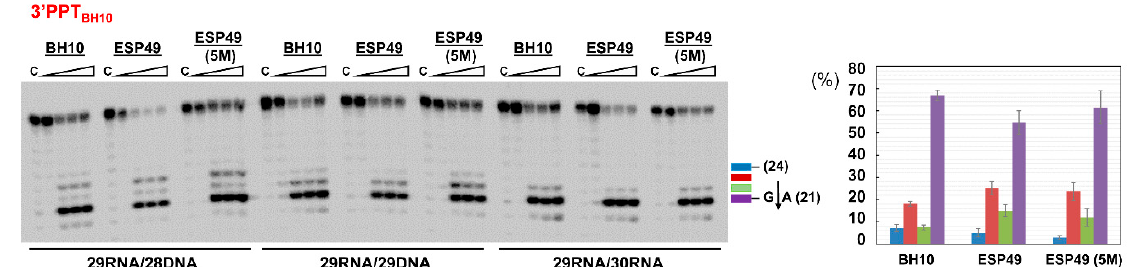
Figure 7. RNase H cleavage specificity of group M and group O HIV-1 RTs. Reactions were carried out in the presence of RT and template-primer at concentrations of 125 nM and 25 nM, respectively. RT and template-primer were pre-incubated for 5 min at 37 ◦ C, and aliquots were withdrawn at 0, 20, 40 and 180 s after the addition of magnesium and heparin. Lane C shows control experiments including heparin in the pre-incubation buffer. Numbers above indicate the template-primer used in each experiment: 29/28, 29/29 and 29/30 for 29RNA/28DNA, 29RNA/29DNA and 29RNA/30DNA hybrids, respectively (see Figure 4A for sequence details). The histogram on the right panel shows the relative amounts of hydrolysis products obtained with template-primer 29RNA/28DNA, representing the 3 ′ PPT BH10 sequence. Represented values were obtained from at least three independent determinations. Blue, red, green and purple bars represent the relative amounts of RNase H cleavage products of 24, 23, 22 and 21 nucleotides, respectively. The 21-nucleotide product derives from cleavage at the PPT/U3 cleavage site (indicated with an arrow in the left panel).